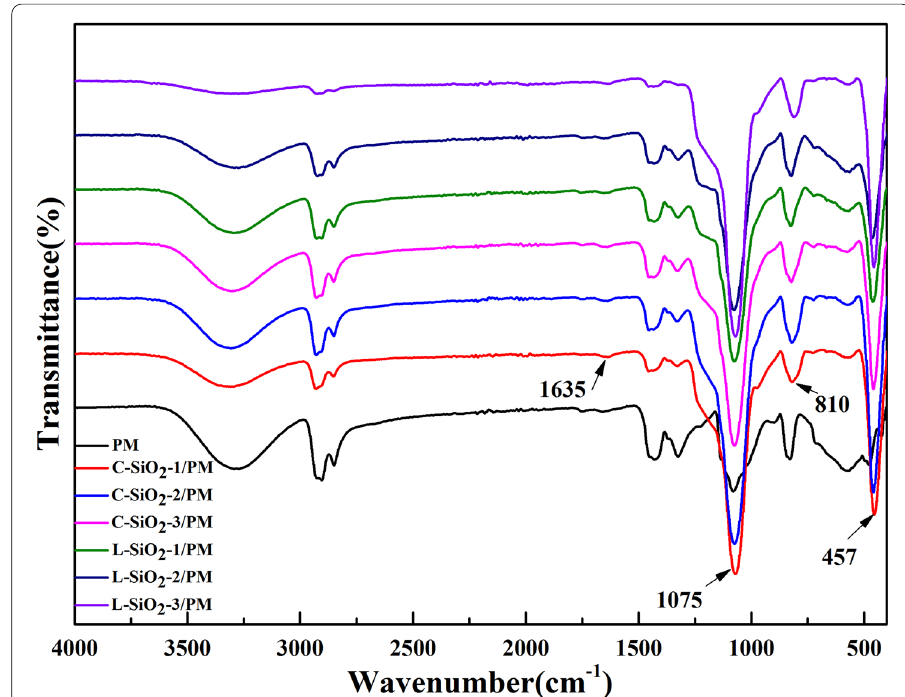
Fig. 2 The FTIR-ATR spectra of PM and silica/PMs